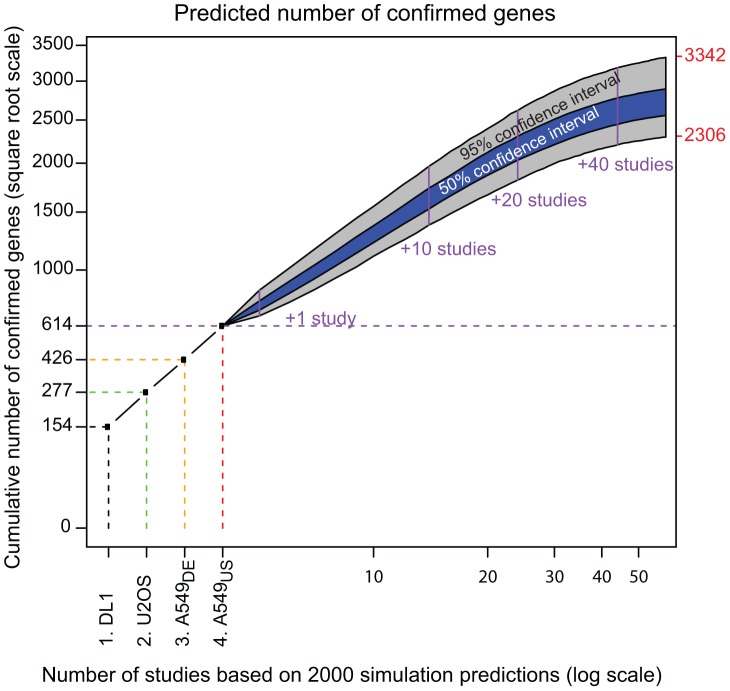
Prediction of findings in similar future studies.If the four analyzed RNAi studies are the first in a possibly long sequence of similar genome wide efforts, one could ask what is likely to happen in the remaining studies. An answer is possible via posterior predictive inference, which accounts for both random fluctuations inherent in study-specific data as well as uncertainty in the system parameters. Summarized above are predictions from 2000 simulated study sequences, with each sequence determined by a parameter setting obtained by Markov chain Monte Carlo and subsequently with future-study counts simulated prospectively from the specified multinomial model. The number of confirmed genes necessarily increases but stabilizes after 12 studies to a range consistent with the inferred number of influenza-involved genes (indicated in red number, as CI 95%). Grey and blue bands express different levels of confidence.